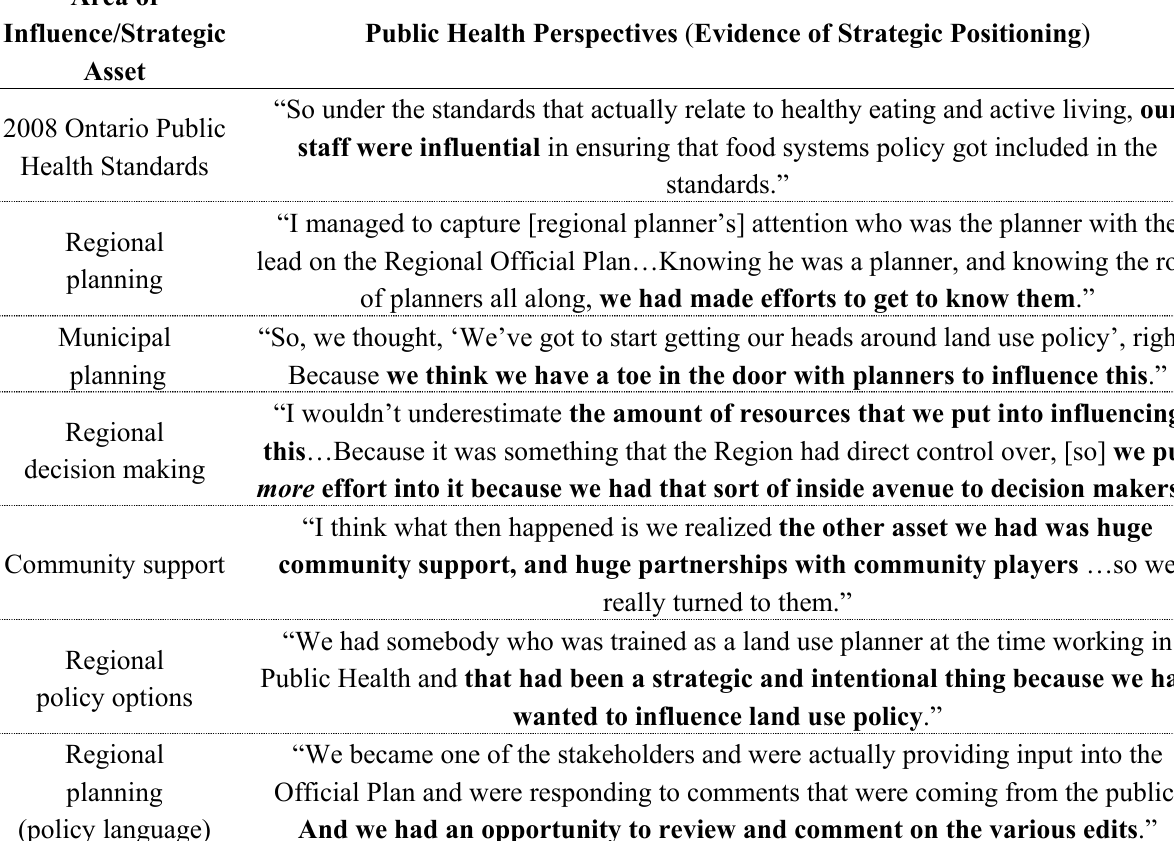
Table 1. Staff expert perspectives on the public health department’s key areas of influence and strategic assets (strategic